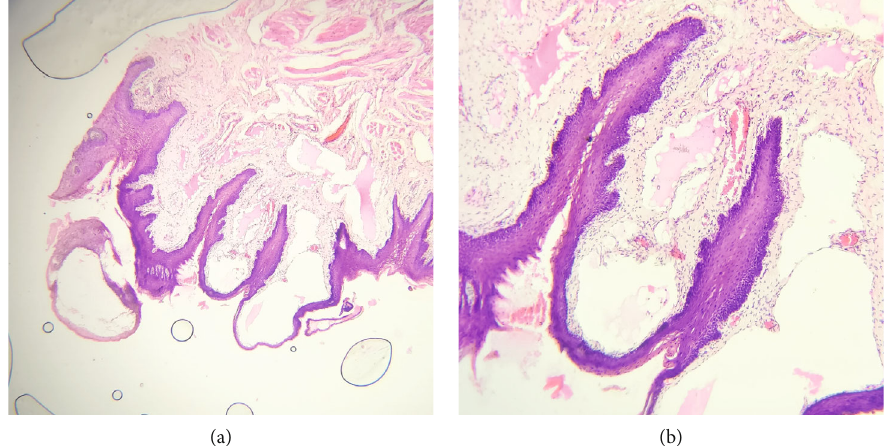
Figure 5: (a) The photomicrograph (10x) reveals the atrophic epithelium beneath which there are numerous dilated lymphatic channels lined by endothelial cells. (b) The photomicrograph (400x) shows large lymphatic channels below the strati fi ed squamous